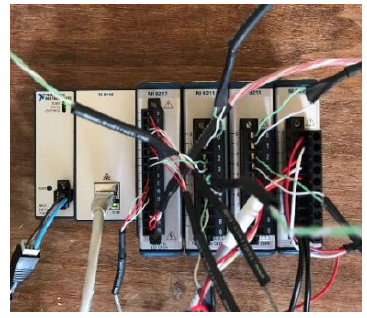
Figure 7. Compact Rio sensor connections.